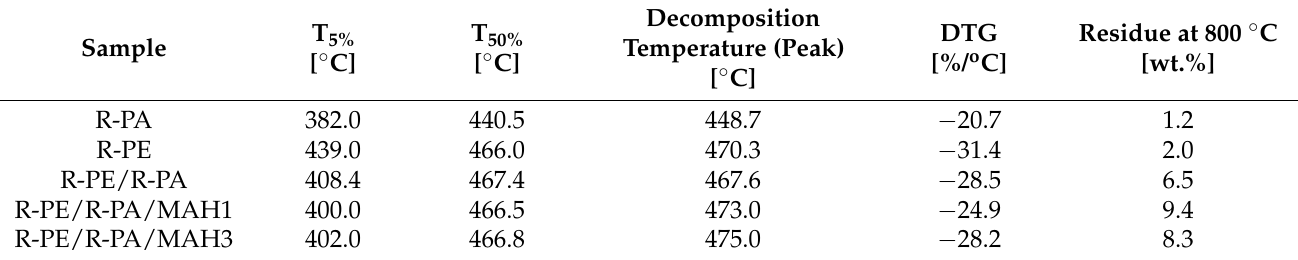
Figure 5. ( a ) TGA and ( b ) DTG curves of R-PE, R-PA, R-PE/R-PA binary blend, and R-PE/R-PA blends grafted by PE-g-MAH (heating rate: 10 ◦ C/min; nitrogen atmosphere). Table 5. Temperature T 5% and T 50% at mass loss of 5 wt.% and 50 wt.%, respectively, maximum peak temperature decomposition, and residual mass at 800 ◦ C for R-PA, R-PE, and their